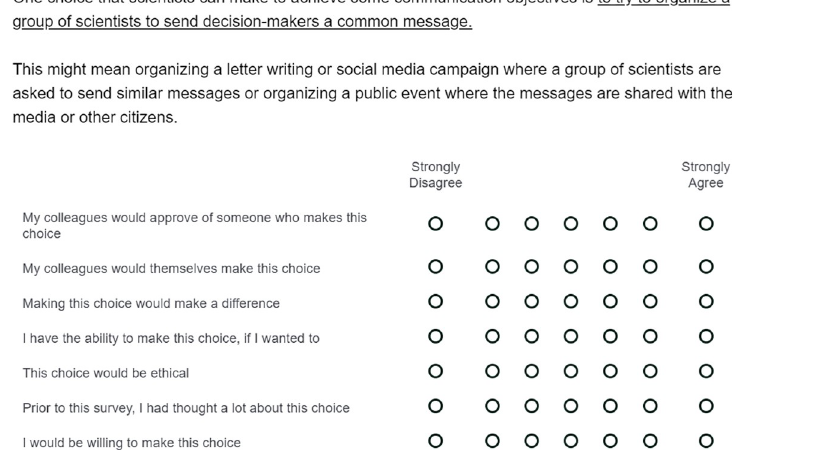
Fig 1. Example of question tactic-focused question